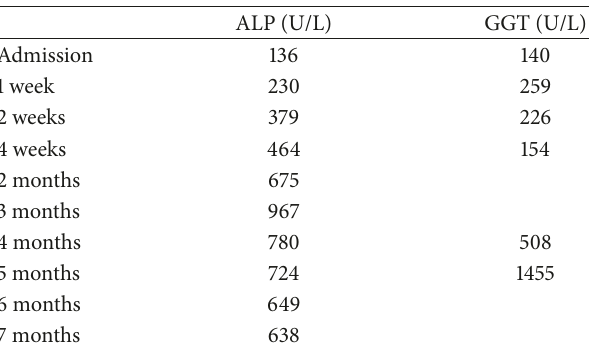
Figure 3: Endoscopic visualization of necrotic biliary cast. Table 1: Cholestatic